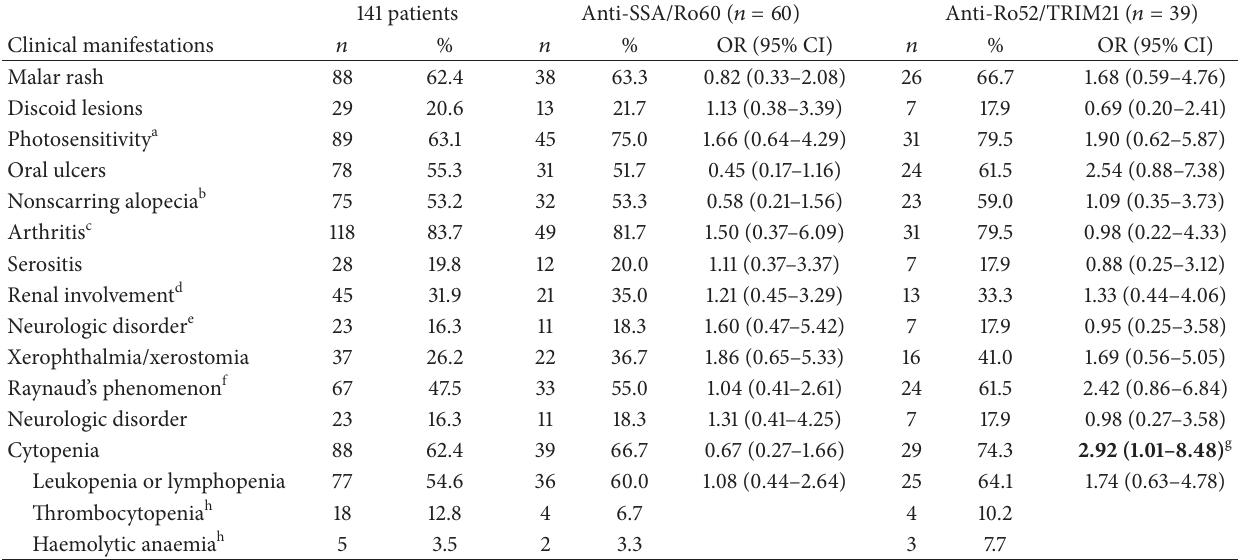
Table 2: Association of anti-SSA/Ro60 and anti-Ro52/TRIM21 with clinical manifestations in